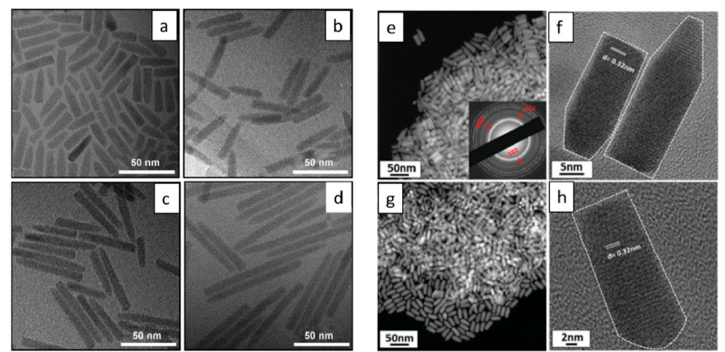
Figure 5. TEM images of Cu-based quaternary NRs, ( a – d ) CIS-ZnS alloyed NRs. Reproduced with permission from [114]. Copyright WILEY-VCH Verlag GmbH & Co. KGaA, Weinheim, 2012. ( e – h ) CZTS NRs with the hot-injection method. Reproduced with permission from [116]. Copyright American Chemical Society, 2012.